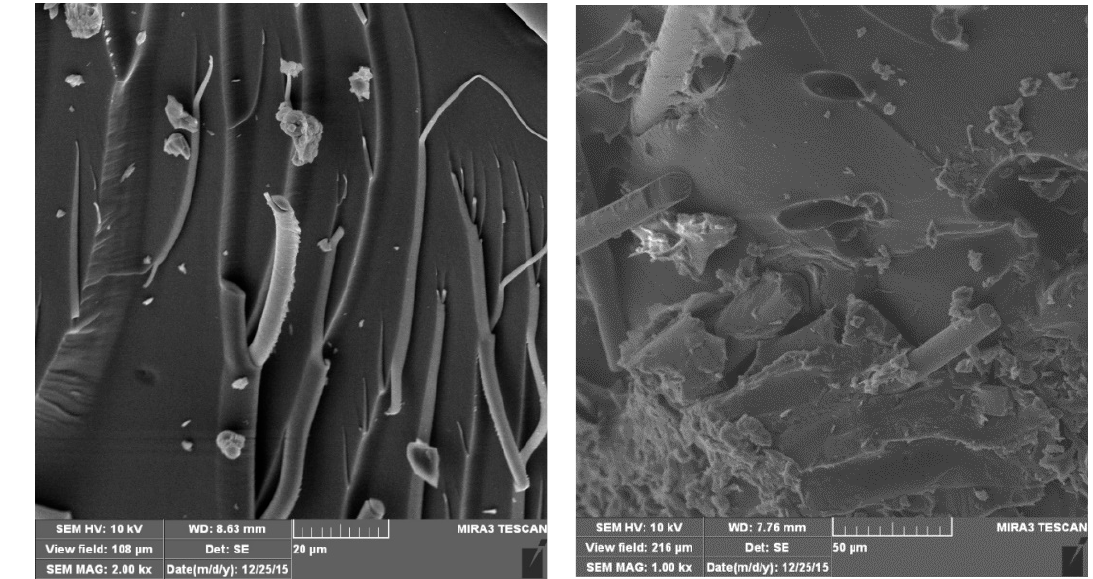
Figure 2. FESEM images of glass fiber–epoxy composite.